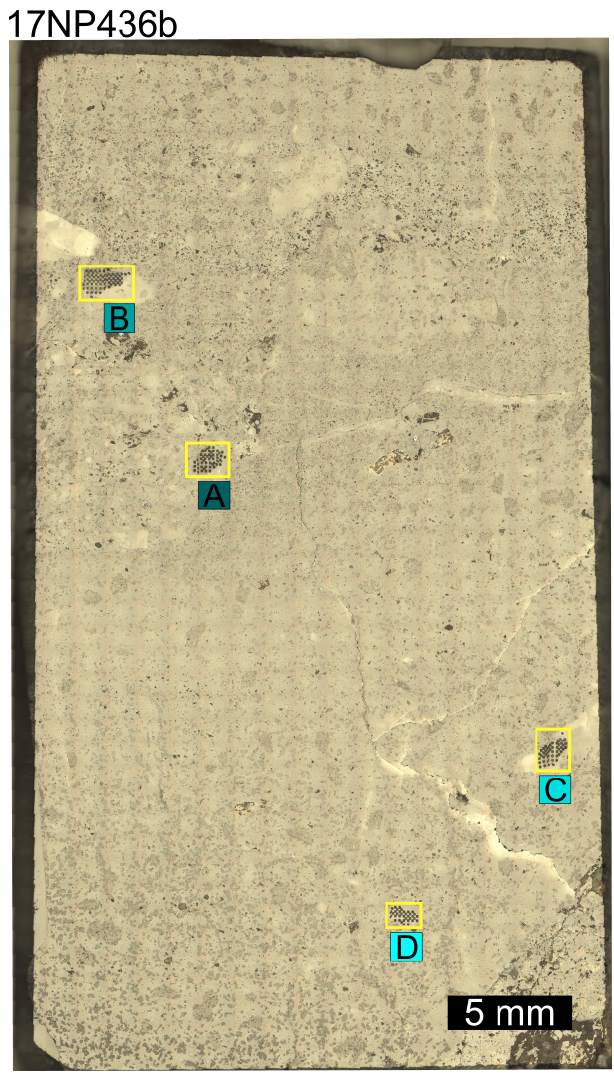
Figure A2. Reflected light image of sample 17NP436b with marked ablation areas. Letter, attached to the yellow boxes, appended to the sample name, labels the ablation areas. Colors of label boxes are consistent with colors of in-text figures.